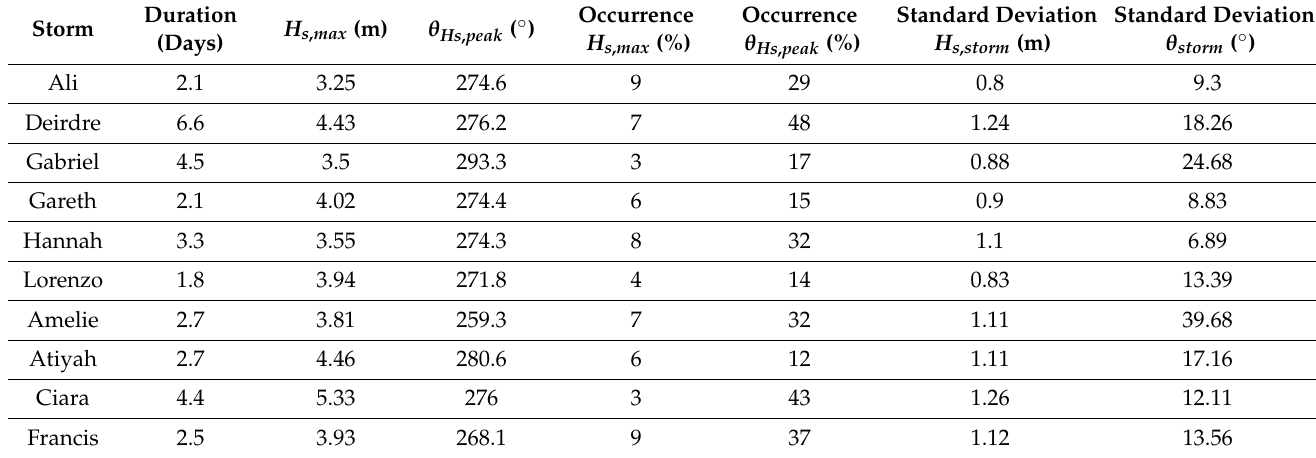
Table 1. Summary of characteristics of the 10 storms in the Reference point selected from June 2018 to September 2020 with the duration, the wave height H s , max , the mean direction θ Hs , peak , the occurrences of H s , max and θ Hs , peak , and the standard deviation of H s , storm and θ storm